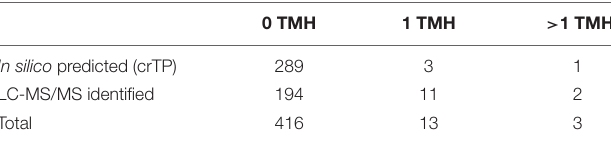
TABLE 1 | Previously identified import candidates do not comprise nucleus-encoded solute